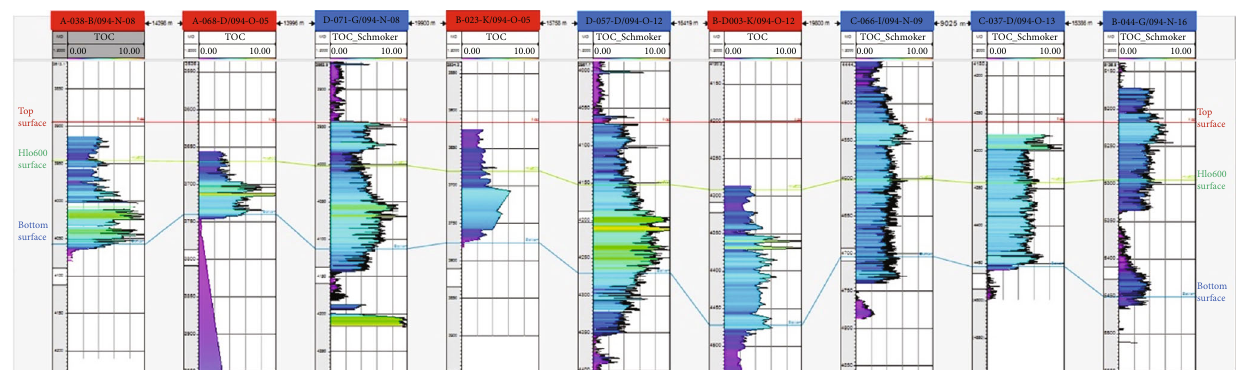
Figure 9: Measured TOCpd (TOC, red color) [17 – 19] and calculated TOCpd (TOC_Schmoker, blue color) using Schmoker ’ s equation.